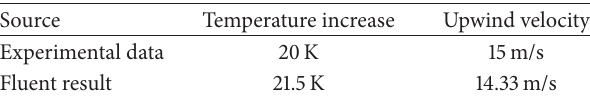
Table3:Thecomparisonofthenumericalresultandtheexperimen- tal